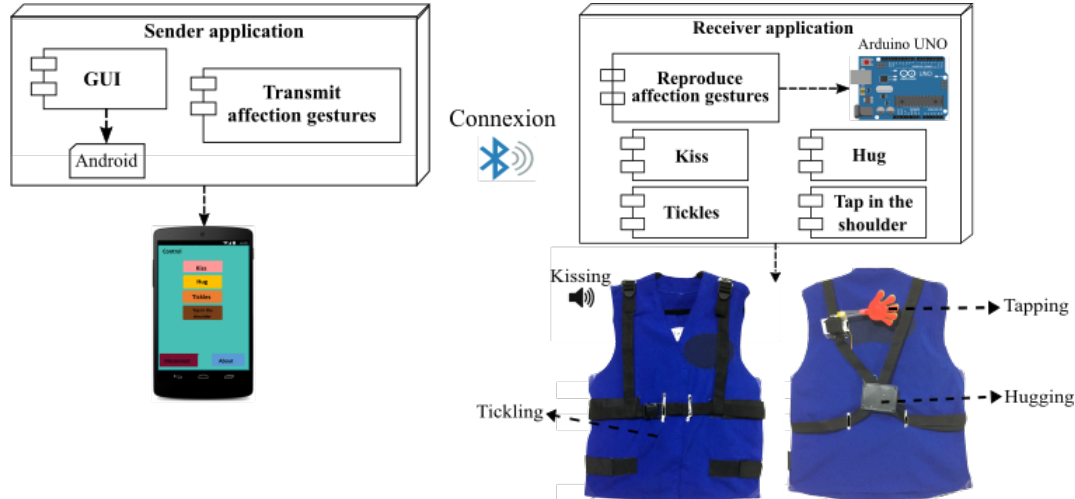
Figure 2. Current architecture of the AffectiVest Affective Wearable Computing (AWC)